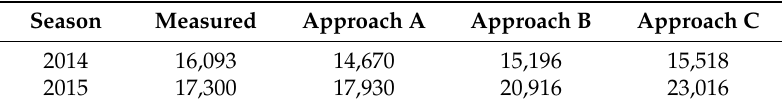
Table 8. Yield (kg ha − 1 )